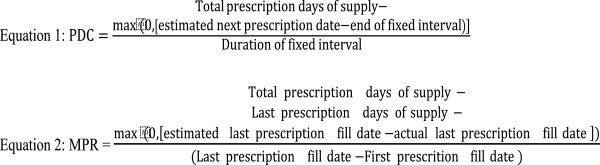
Adherence Equations.